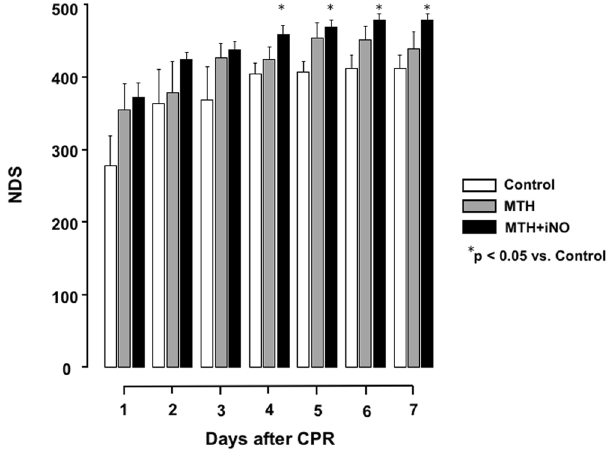
Figure 3. Neurological Deficit Score. Though animals of the MTH and iNO group presented with significantly improved neurological function on day four to seven post-arrest in comparison to Controls, no significant differences were observed in comparison to animals treated with MTH alone. * p < 0.05 vs. control; mean ± SEM.